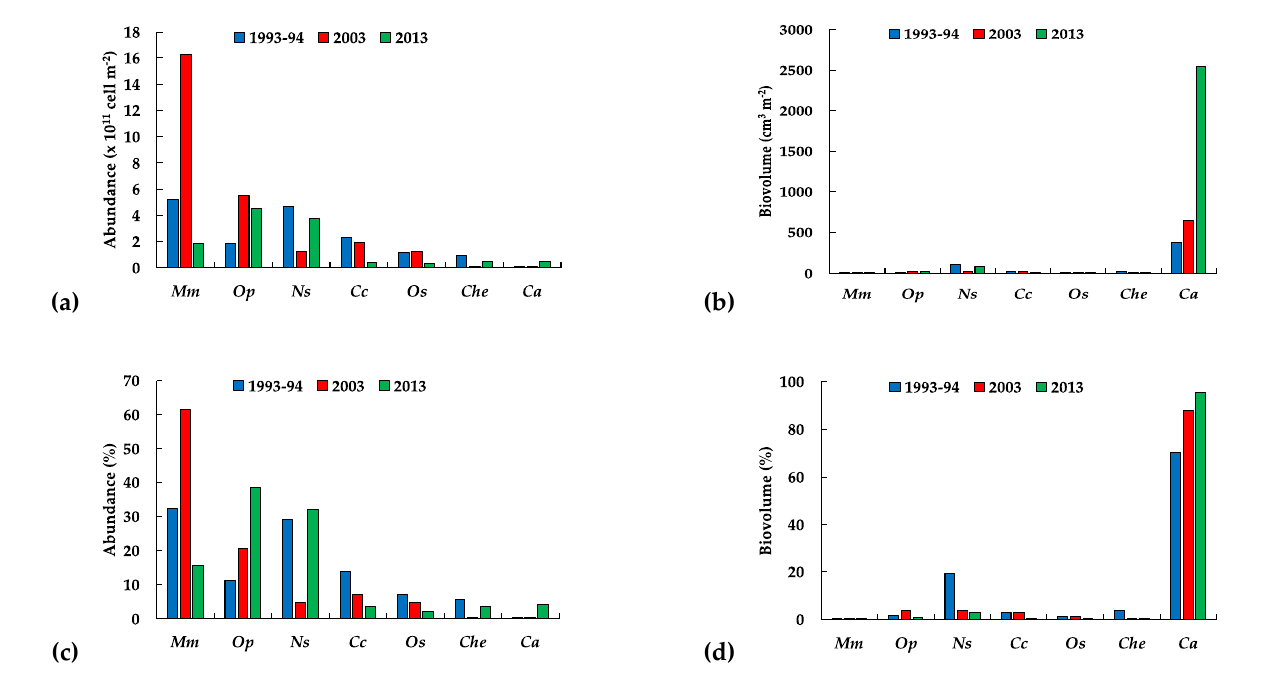
Figure 9. Per species contribution to absolute ( a ) and relative ( c ) abundance and absolute ( b ) and relative ( d ) biovolume of the seven main phytoplankton species in Lake Alchichica in the 3 annual cycles. ( Mm : Monoraphidium minutum , Op : Oocystis parva , Ns : Nodularia aff. spumigena , Cc : Cyclotella choctawhatcheeana , Os : Oocystis submarina , Che : Chaetoceros elmorei , Ca : Cyclotella alchichicana ).